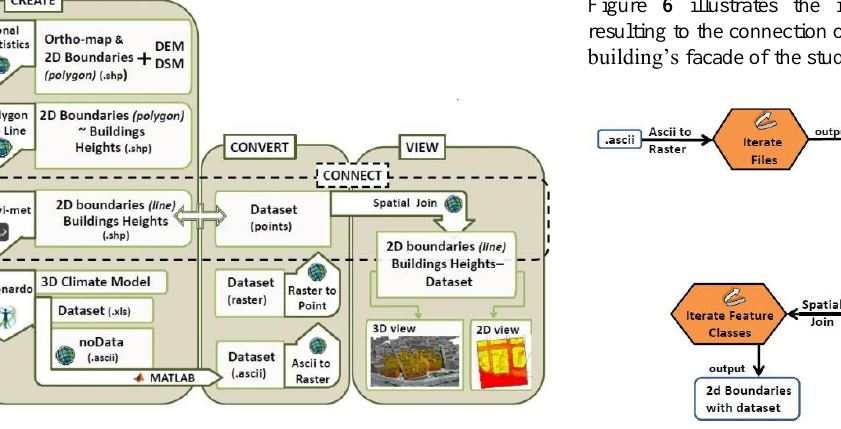
Figure 6: Iteration process through